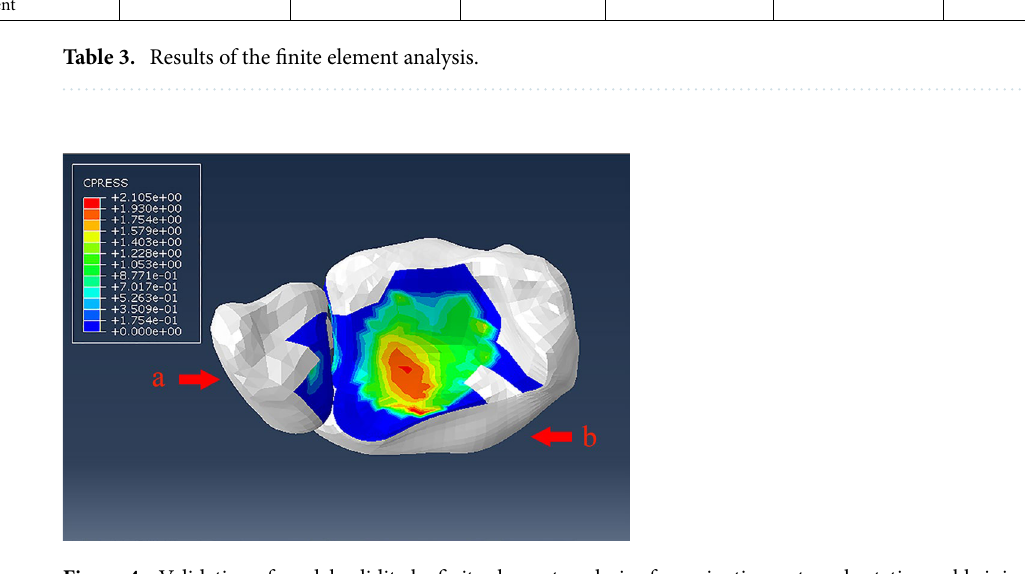
Figure 4. Validation of model validity by finite element analysis of a supination-external rotation ankle injury. a: Tibia. b: